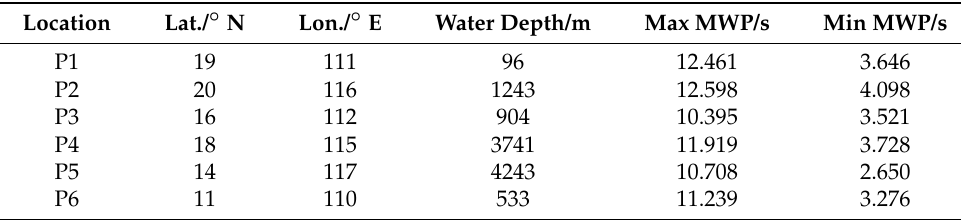
Table 1. The latitude, longitude, water depth, and the maximum and minimum Mean wave period (MWP) at six points. Location Lat./ ◦ N Lon./ ◦ E Water Depth/m Max MWP/s Min MWP/s P1 19 111 96 12.461 P2 116